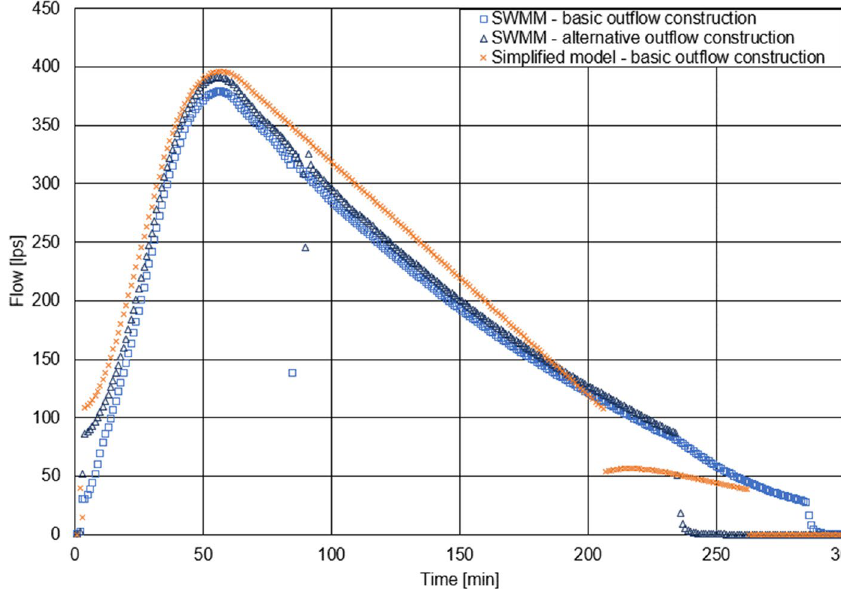
Fig. 4 Outflow from the